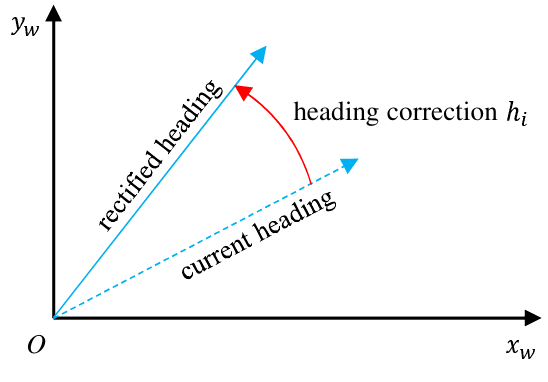
Figure 8. Definition of heading correction h i